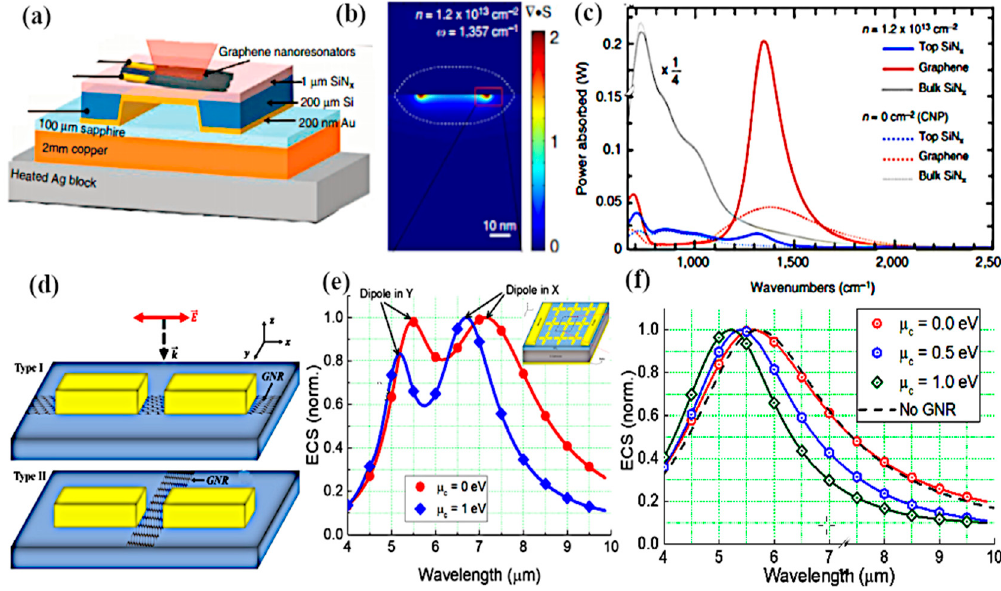
Figure 11. ( a ) Geometry of graphene nano-resonators placed on a silicon nitride (SiN) substrate having a thickness of 1 µm and a back reflector of AU material of 200 nm thin membrane. The gate voltage is applied through SiN substrate and graphene sheet. Copper of 2 mm thickness is employed for temperature control base for the heating of silver layer, while a layer of sapphire is used for electrical isolation. ( b ) Finite element simulation of graphene nanoresonator for plasmon resonance, which has the carrier density of 1.2 × 10 13 cm − 2 , by using 40 nm graphene resonator on 1- µ m SiN with gold as a back reflector. ( c ) Power density and absorption comparison of a 40-nm graphene resonator on top of a bulk silicon nitride substrate. ( d ) Dipole antenna loaded with graphene: Type 1 has a graphene layer below the dipole arms and in horizontal position, while Type 2 has a graphene layer in vertical position and is placed between the dipole gap. ( e ) Normalized extinction cross-section (ECS) of graphene–metal antenna, where the blue line represents ECS of the dipole with longer arms at x-coordinate with chemical potential of 1 eV, while the red line is with respect to zero chemical potential. ( f ) Tuning of resonance frequency of Type 1 antenna with increasing chemical potential. Copyright © 2015